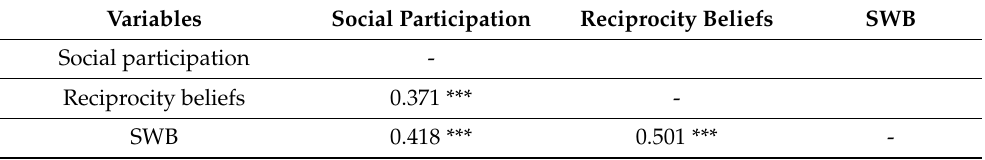
Table 3. Correlations between social participation, reciprocity beliefs, and SWB of older women. Variables